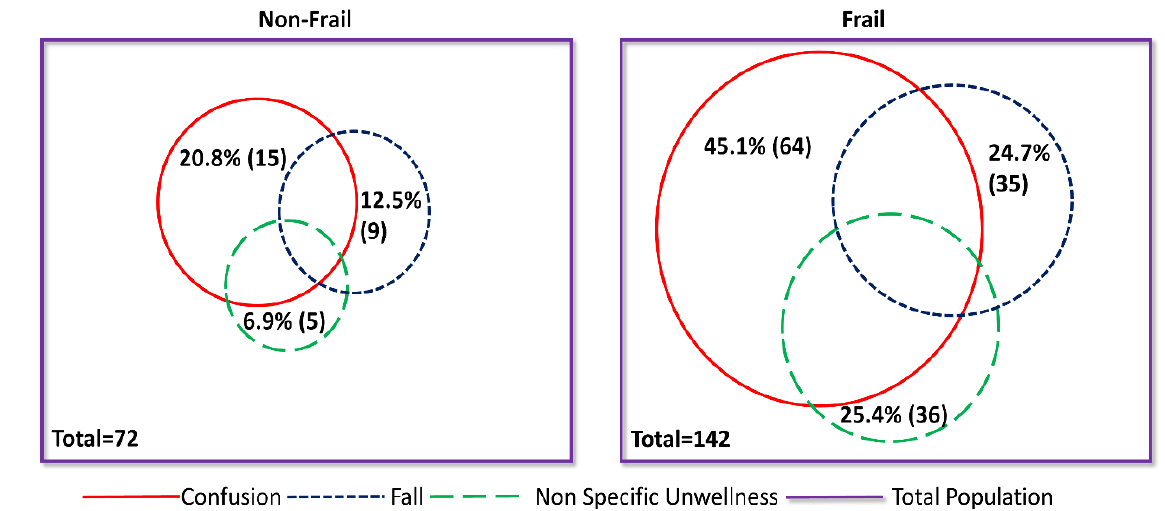
Figure 1. Venn Diagrams illustrating the prevalence of common geriatric illness by frailty with COVID-19 infection. Nonfrail: